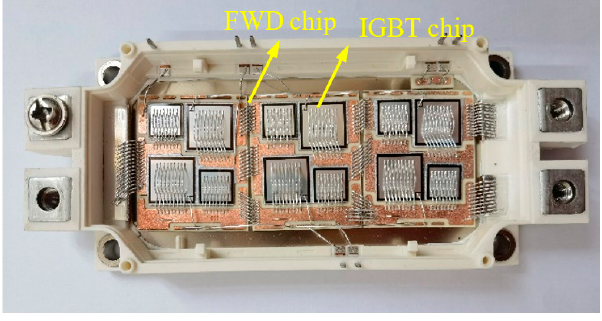
Figure 1. IGBT module to be tested.